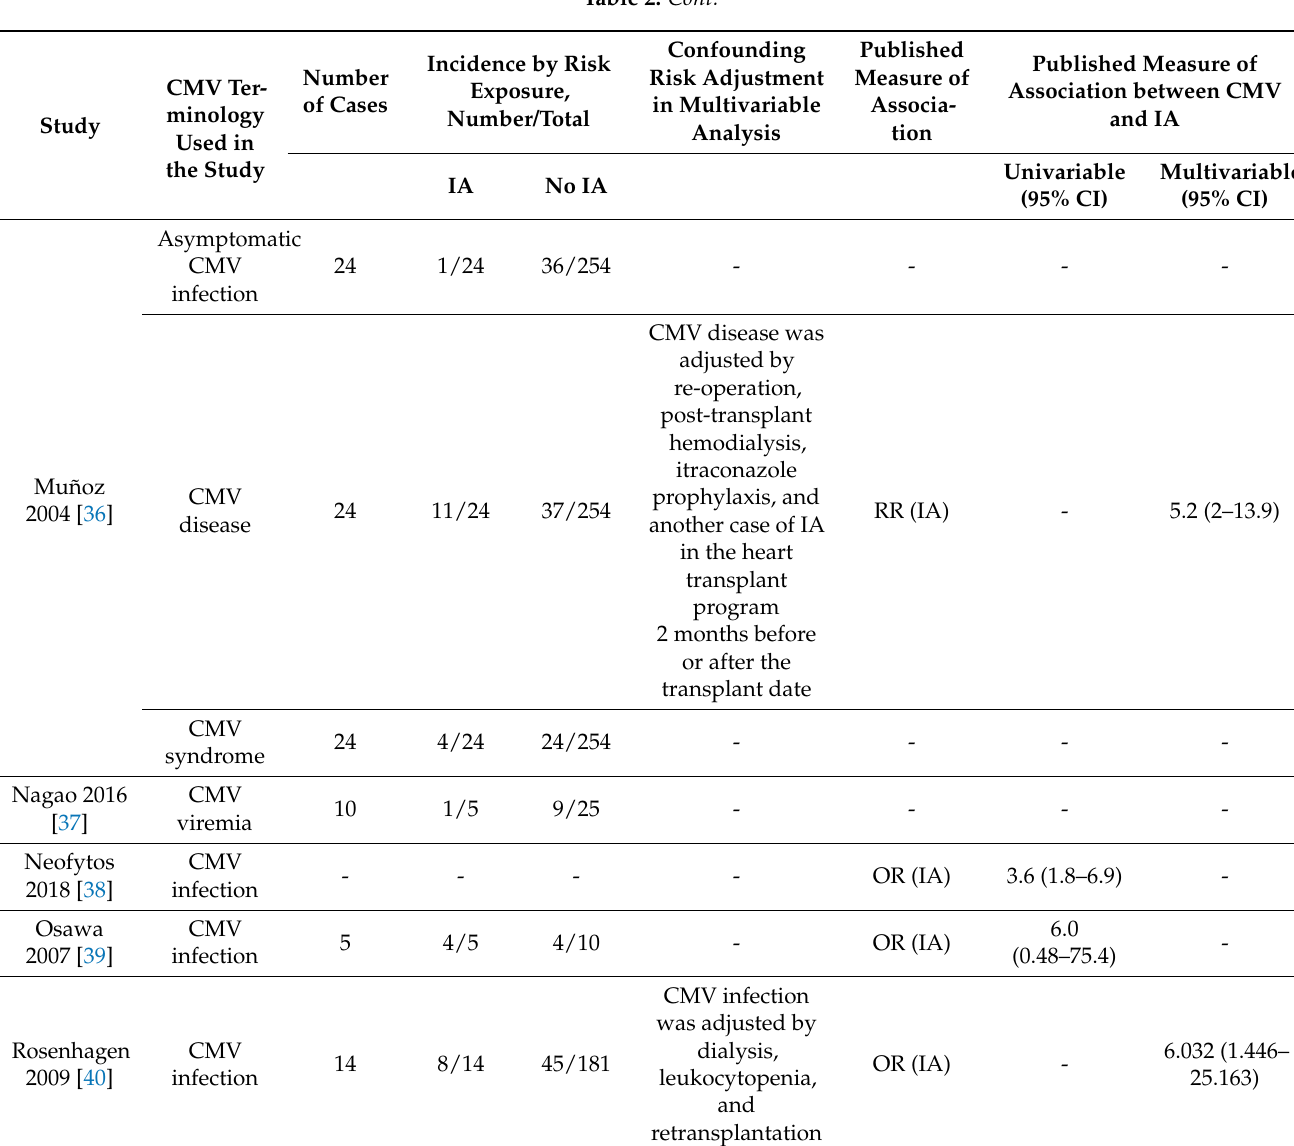
invasive aspergillosis group: CMV disease/syndrome vs. Asymptomatic CMV viremia/infection. Figure S4. Subgroup analysis in invasive aspergillosis group by study period: Before 2003 vs. After 2003. Figure S5. Subgroup analysis in invasive aspergillosis group: Early IA vs. Late IA. Figure S6. Subgroup analysis in invasive aspergillosis group: Intra-abdominal transplantation vs. Intra-thoracic transplantation. Figure S7. Subgroup analysis by adjustment of effect estimates between cytomegalovirus and invasive